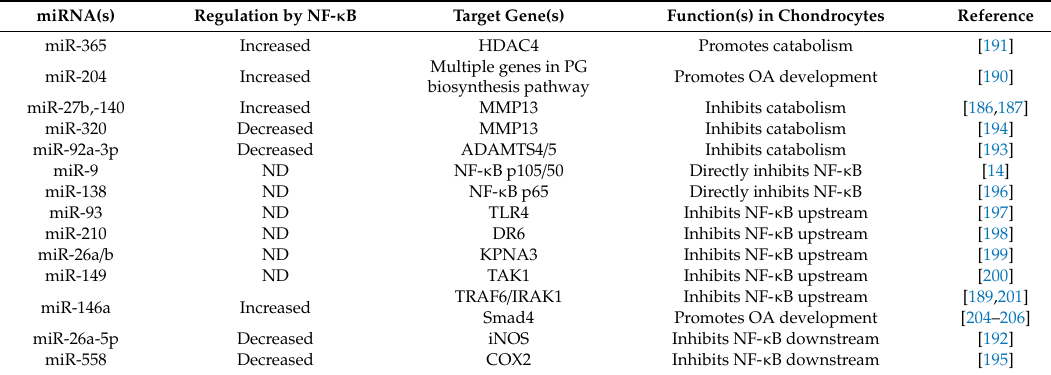
Table 1. The microRNAs involved in nuclear factor-kappaB (NF- κ B) signaling in Osteoarthritis (OA)